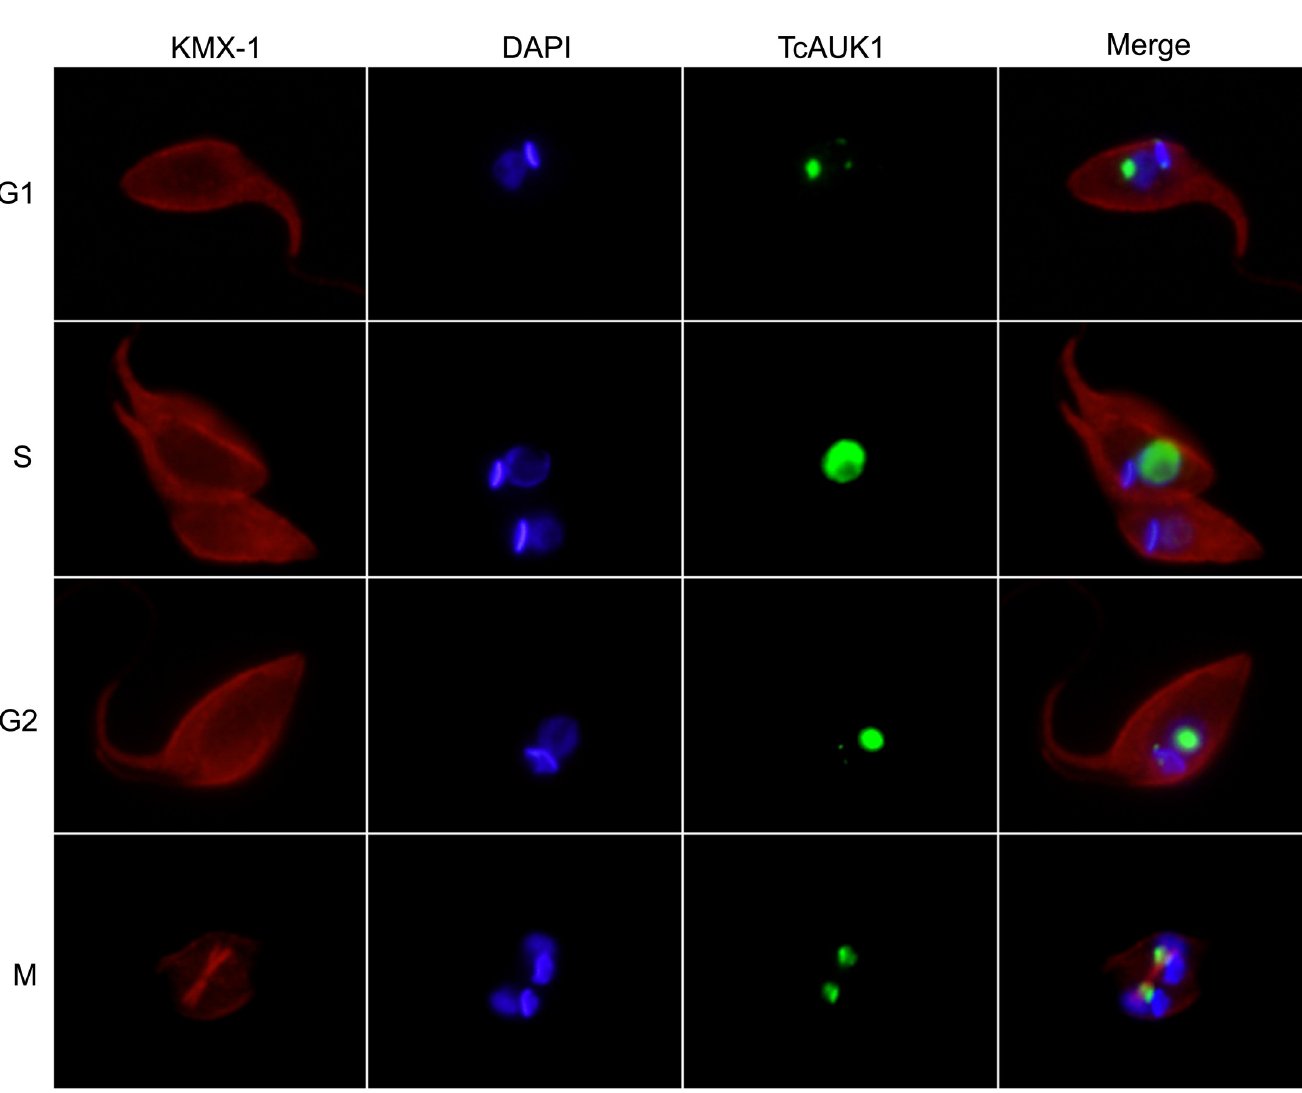
Fig 8. TcAUK1 localization in synchronized overexpressing epimastigotes. TcAUK1 overexpressing epimastigotes, at different phases of cell cycle, were stained for mitotic spindle (mouse monoclonal KMX-1 antibody), TcAUK1 (rabbit antiserum to TcAUK1) and nucleus/kinetoplast (DAPI).